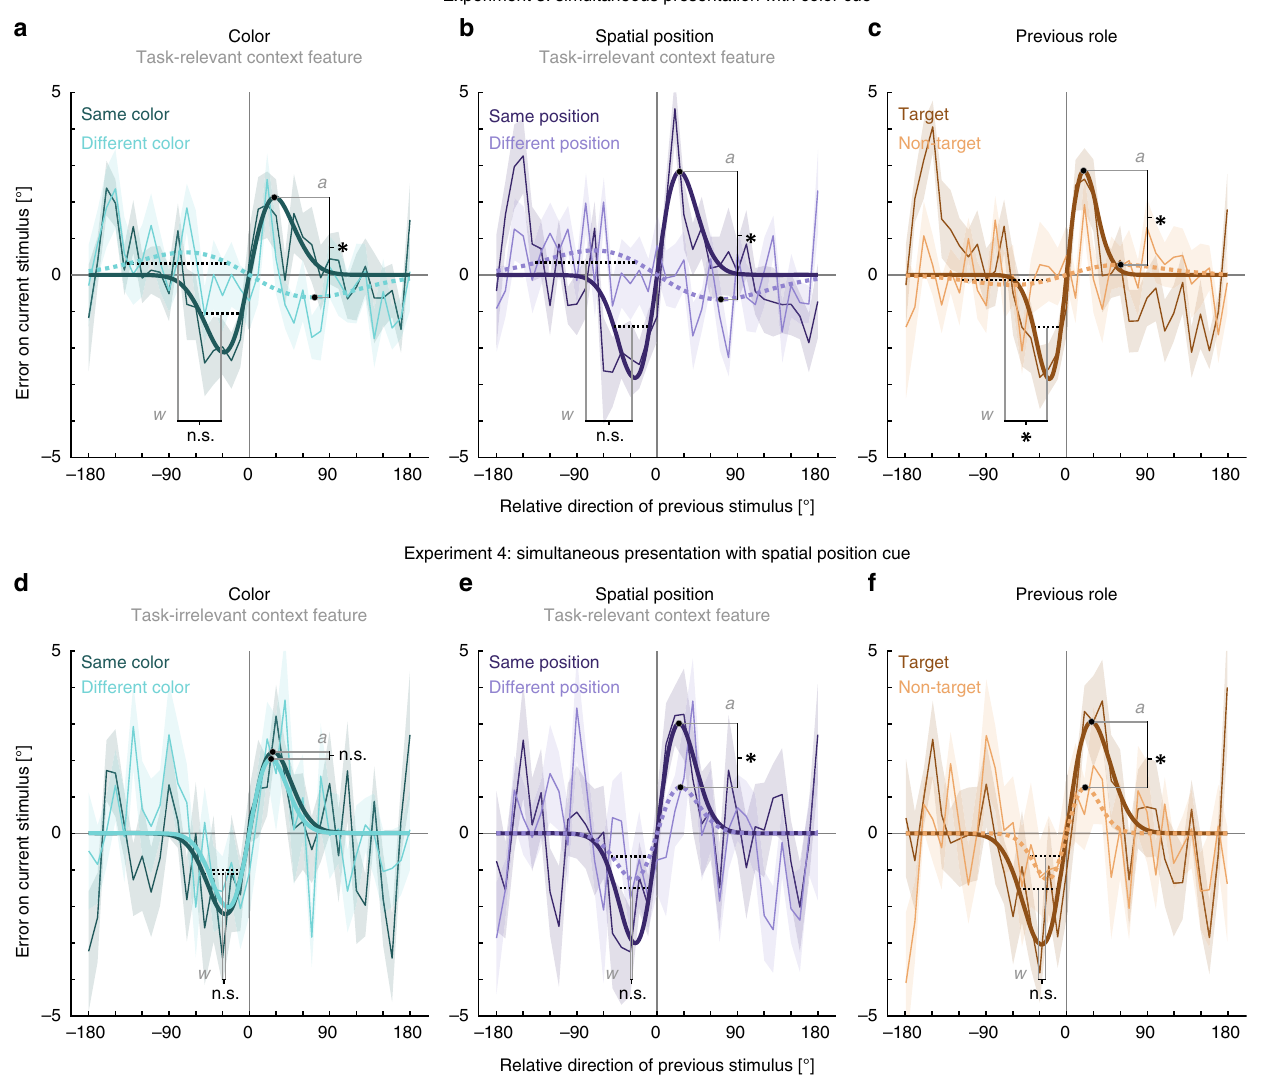
Fig. 5 Results of Experiments 3 and 4. Serial dependence (ordinate) is shown as a function of the motion direction difference (abscissa) between an item of the previous trial and the target of the current trial (Experiment 3: panels a – c , Experiment 4: panels d – f ). For details, see Fig. 2 and Methods. Serial dependence was revealed by the group averages of response errors (thin lines), with the corresponding shaded regions depicting the standard error of the group mean. A DoG model (shown as bold lines) was fi tted to the response errors to estimate the systematic response bias. Solid lines indicate a signi fi cant bias, whereas dashed lines depict a non-signi fi cant bias. Black fi lled circles and black dashed lines show the amplitudes and FWHMs of the DoG fi ts and are accompanied by a symbol indicating the result of the direct comparison of the parameter estimates (one-sided permutation tests, 20 participants per Experiment). Asterisks indicate a p -value < 0.05 and ‘ n.s. ’ indicates a non-signi fi cant result with a p -value ≥ 0.05. a Serial dependence was observed between items with the same color, but not between items with different colors (amplitude difference: p = 0.005, width difference: p = 0.153). b Serial dependence was observed between items with the same spatial position, but not between items with different spatial positions